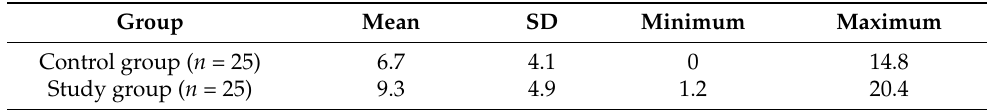
Table 2. Anteroposterior position (mm) of the maxillary central incisors relative to the forehead’s forehead facial axis point (distance between lines 1 and 2). Group